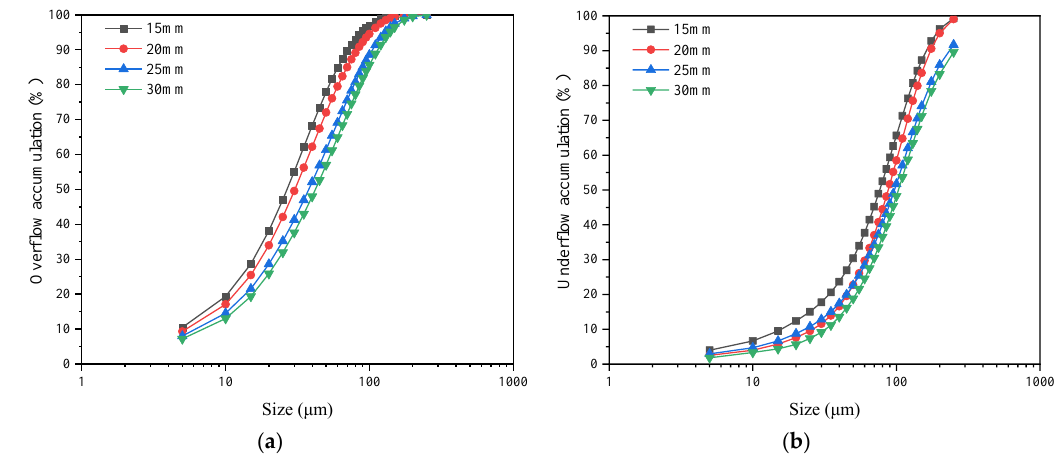
Figure 16. The product particle size: ( a ) Overflow particle size; ( b ) Underflow particle size.